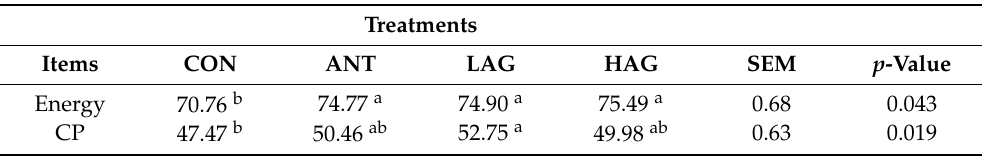
Effects of Astragalus-Glycyrrhiza polysaccharides on apparent metabolic rate of nutrients in broilers